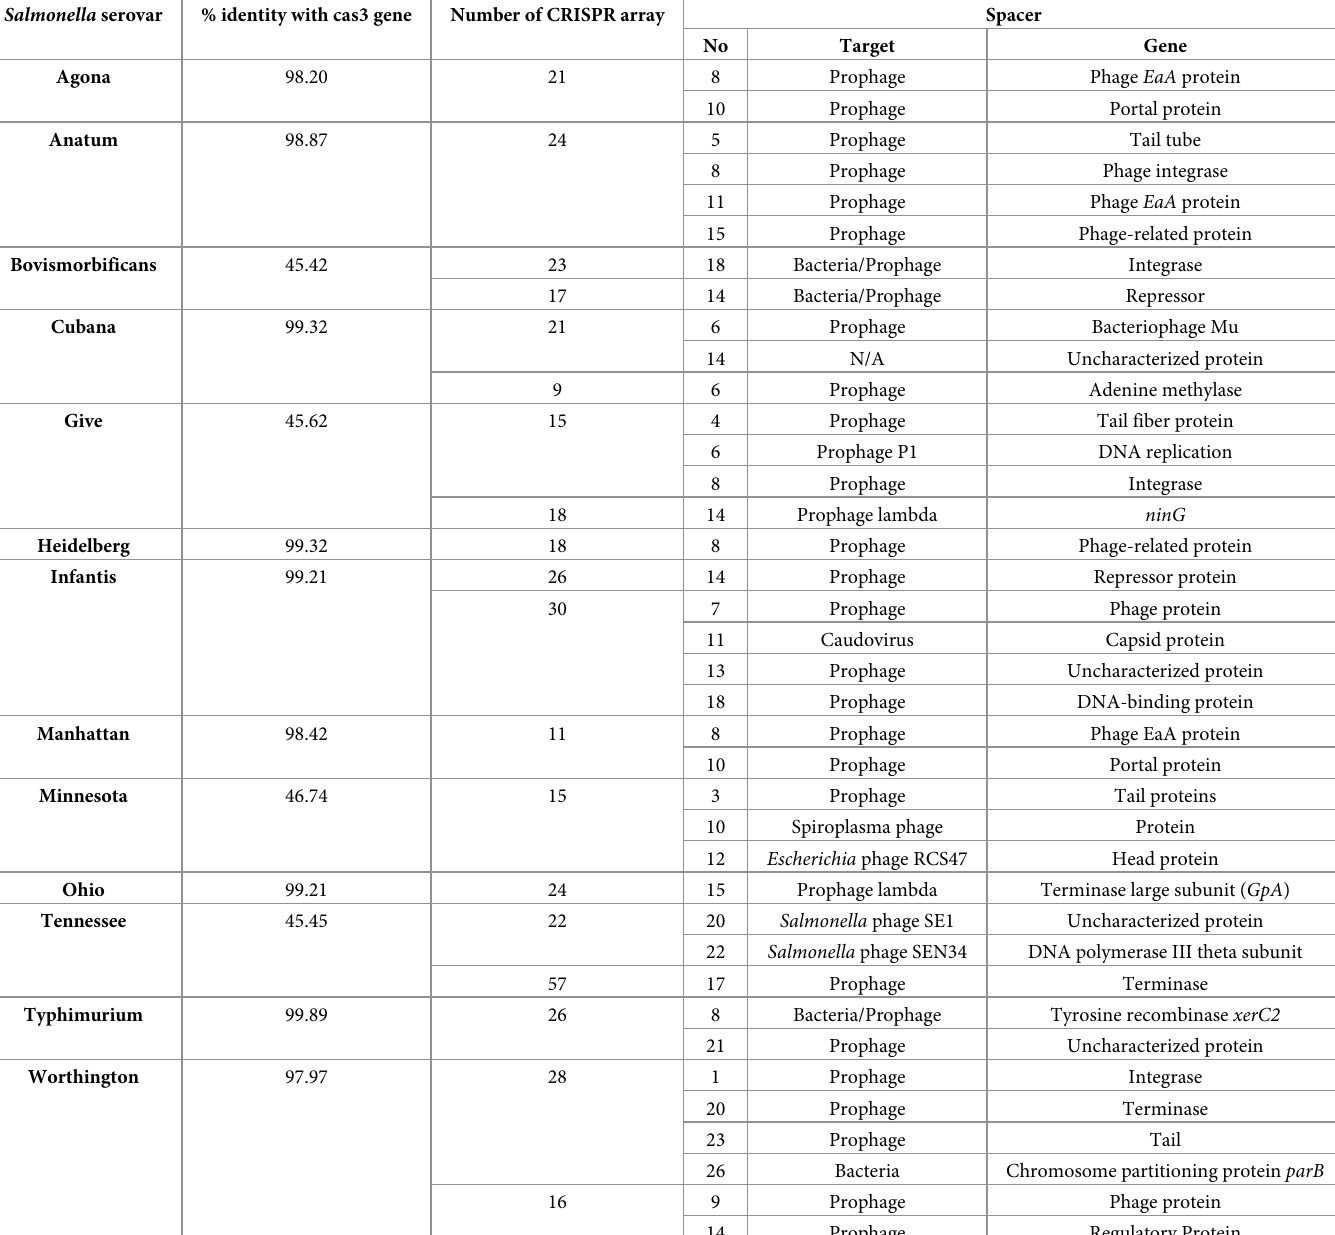
Table 5. Prophage target identified in spacer sequences in CRISPR arrays in Salmonella serovars. Salmonella